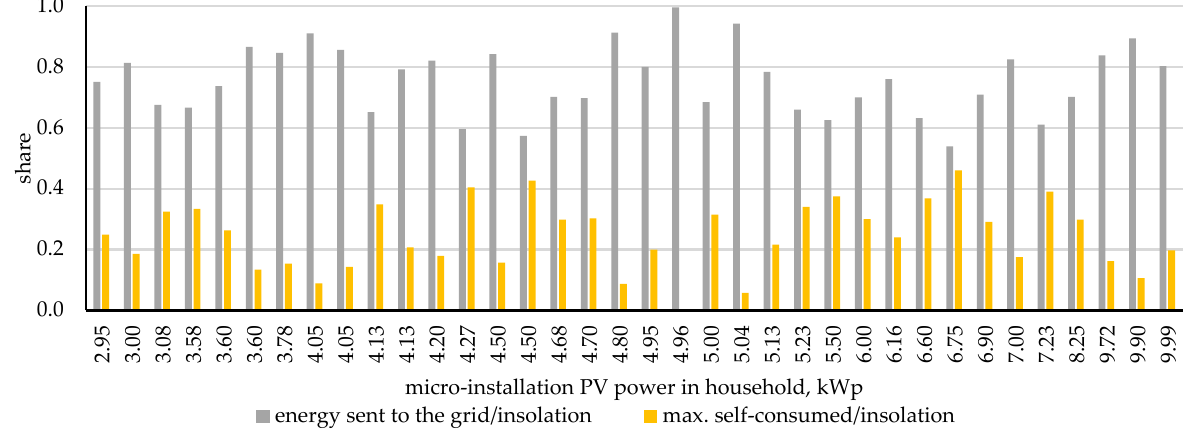
Figure 3. Annual values of energy sent to the grid in relation per kWp to insolation and the maximum annual self-consumed (max. self-consumed/insolation) share, in the Lesser Poland province, 1 June 2019–31 May 2020. Source own study based on [32].